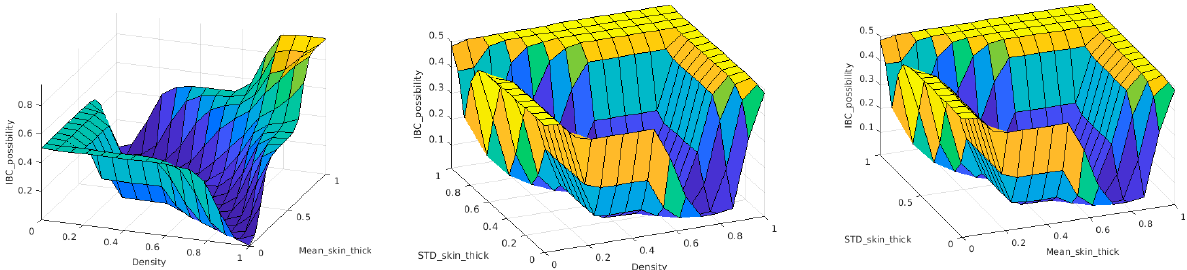
Figure 13. Decision surface of the proposed Type-2 fuzzy classifier.